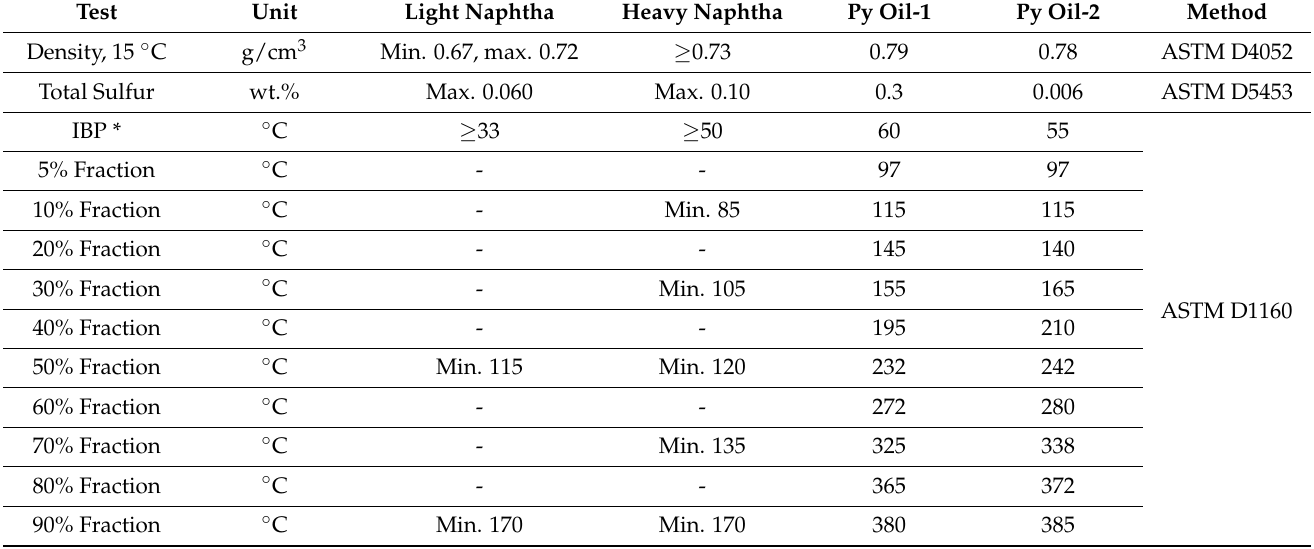
Table 1. Density, vacuum distillation, and total sulfur